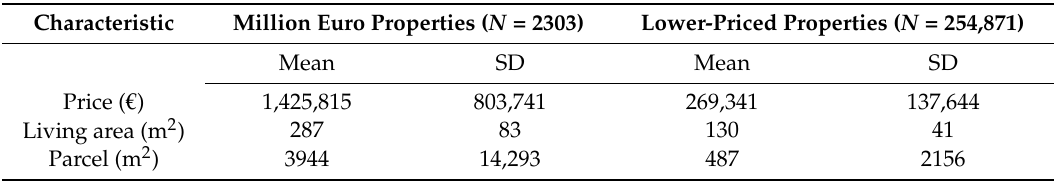
Table 1. Property characteristics. i